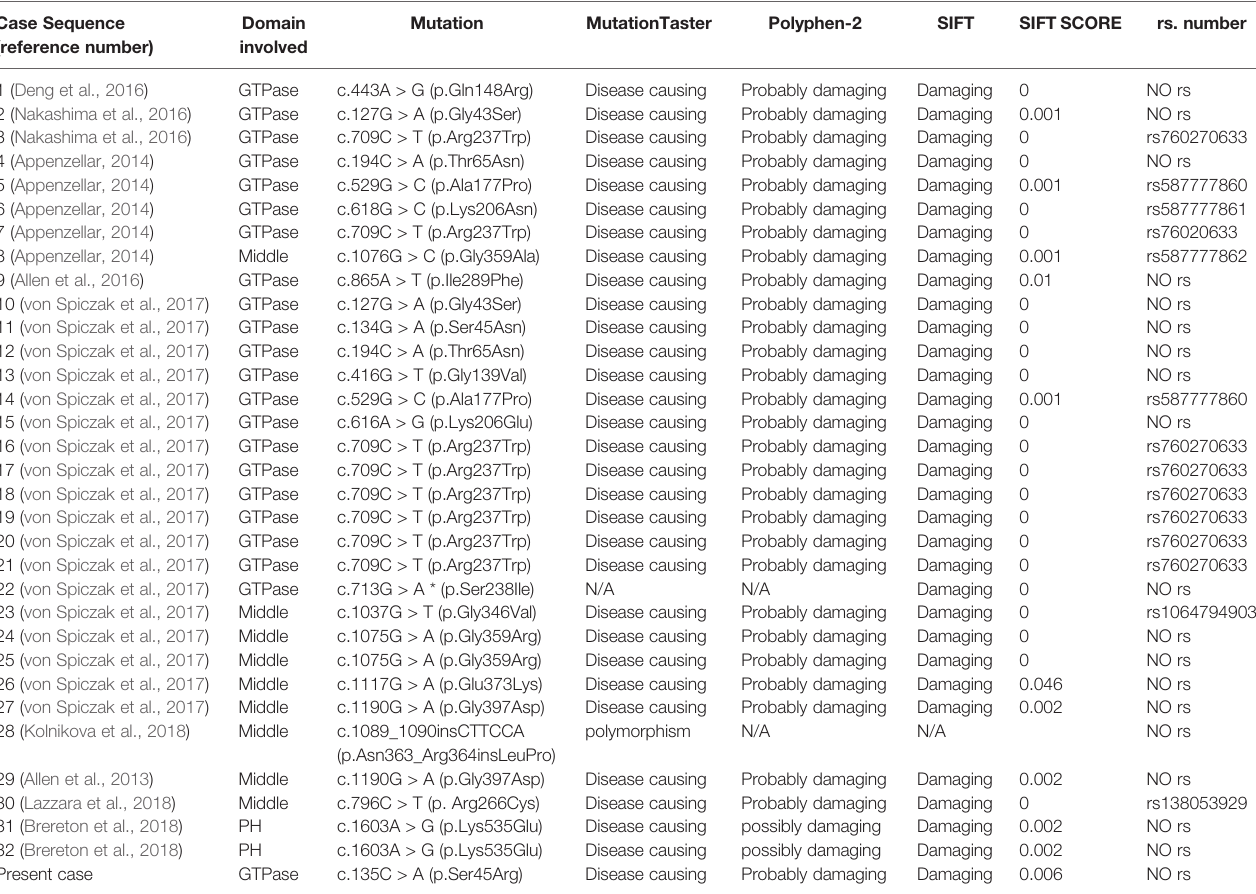
TABLE 2 | Details of the DNM1 mutations variants of 33